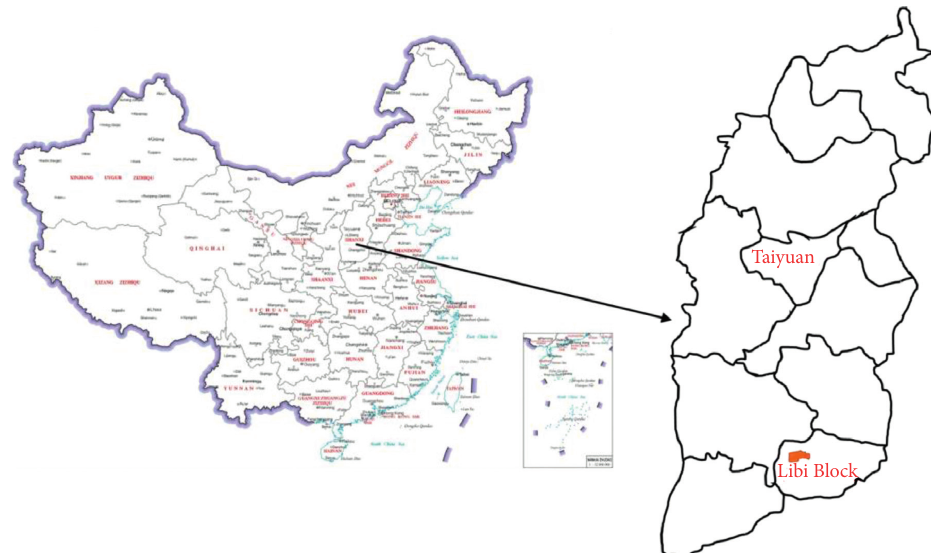
Figure 1: Schematic diagram illustrating the Libi Block location. Table 1: Mechanical parameters of the coal seam in the southern Qinshui basin, alongside with its roof and floor [28]. Compressive strength Tensile strength Elastic Stratum (MPa) (MPa)